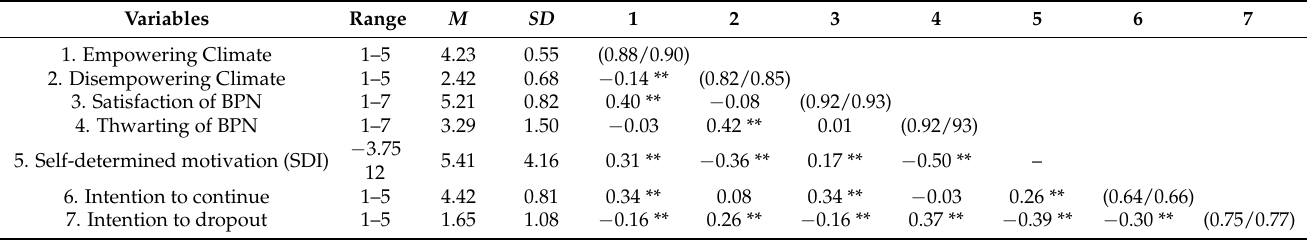
Table 2. Descriptive statistics, reliability and correlations between